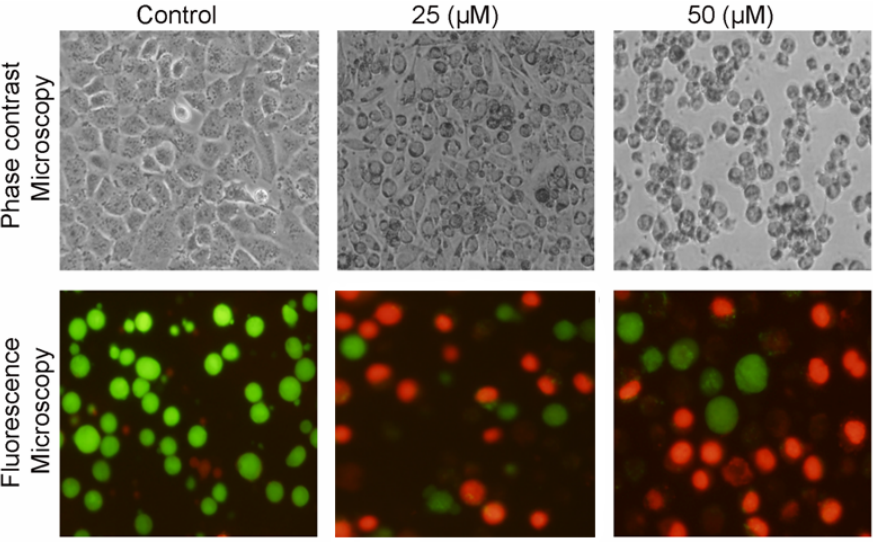
Figure 3. Morphological changes in human bladder cancer T24 cells were observed under phase contrast and fluorescence microscopy after treatment with 0, 25 and 50 μ M of costunolide for